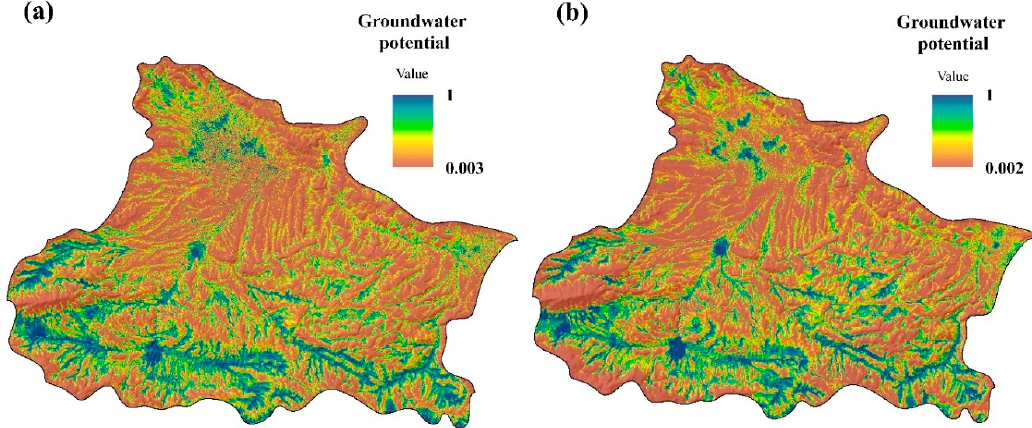
Figure 10. Groundwater potential maps of the study area produced using the multivariate adaptive regression splines (MARS) model and based on: ( a ) the simple random method, and ( b ) the selection of absence samples (SAS) method. Table 7. Statistical characteristics of the probability values obtained from the random forest (RF) and multivariate adaptive regression splines (MARS) models based on the simple random and selection of absence samples (SAS) methods.